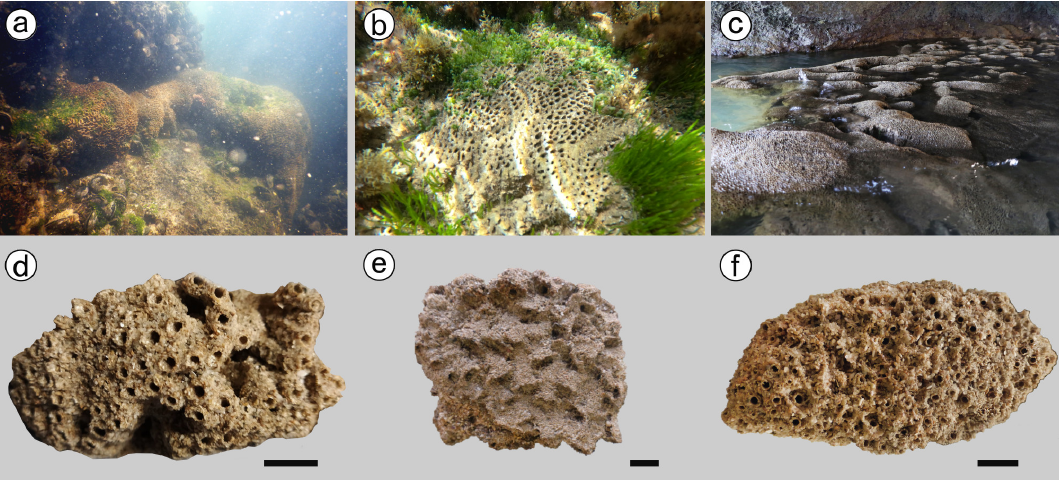
Figure 2Figure 2. Bioconstructions of S. alveolata at the three Sicilian sites and related sampled portions: ( a , d ) pillow-like morphology (Simeto), ( b , e ) crust-like morphology (Portopalo), ( c , f ) bank-like mor- phology (Falconara). Scale bars: 1